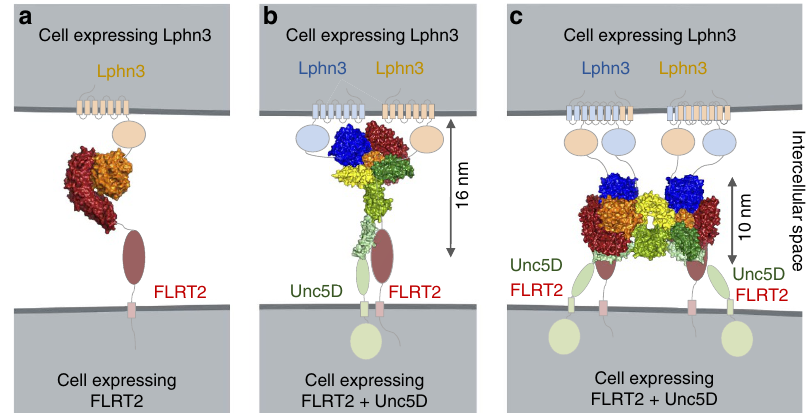
Figure 8 | Arrangements of receptor super-complexes at the cell surface. ( a ) Current data support the idea that FLRTand Lphn engage in an adhesive in trans interaction across the synapse in a 1:1 stoichiometry. ( b ) 1:1:2 complexes, corresponding to one of the pseudo-symmetric halves in the complex structure of Unc5D IgIgTSP , FLRT2 LRR and Lphn3 Lec–Olf , are presumably formed by all Unc5, FLRTand Latrophilin homologues. ( c ) Unc5D þ FLRT2 þ Lphn3 form large (2:2:4) complexes in which two Unc5D ectodomains are arranged in an anti-parallel fashion. In our stripe assay, where Lphn3 Lec–Olf is presented in trans to Unc5D þ FLRT2-expressing cells, the formation of this complex in cis would be